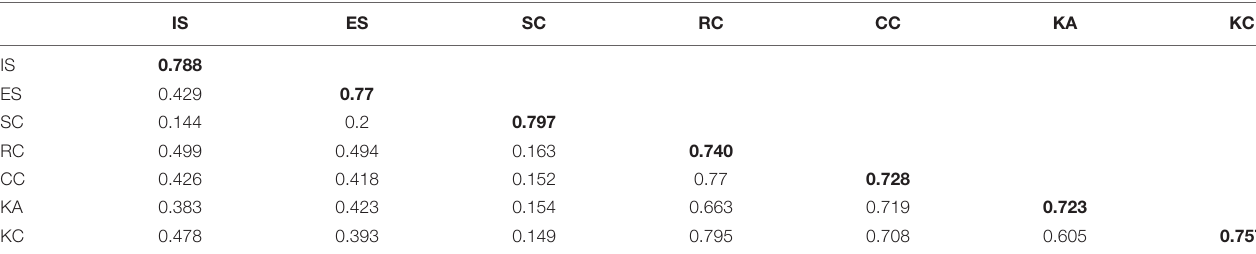
TABLE 3 | Matrix of correlation constructs and discriminant